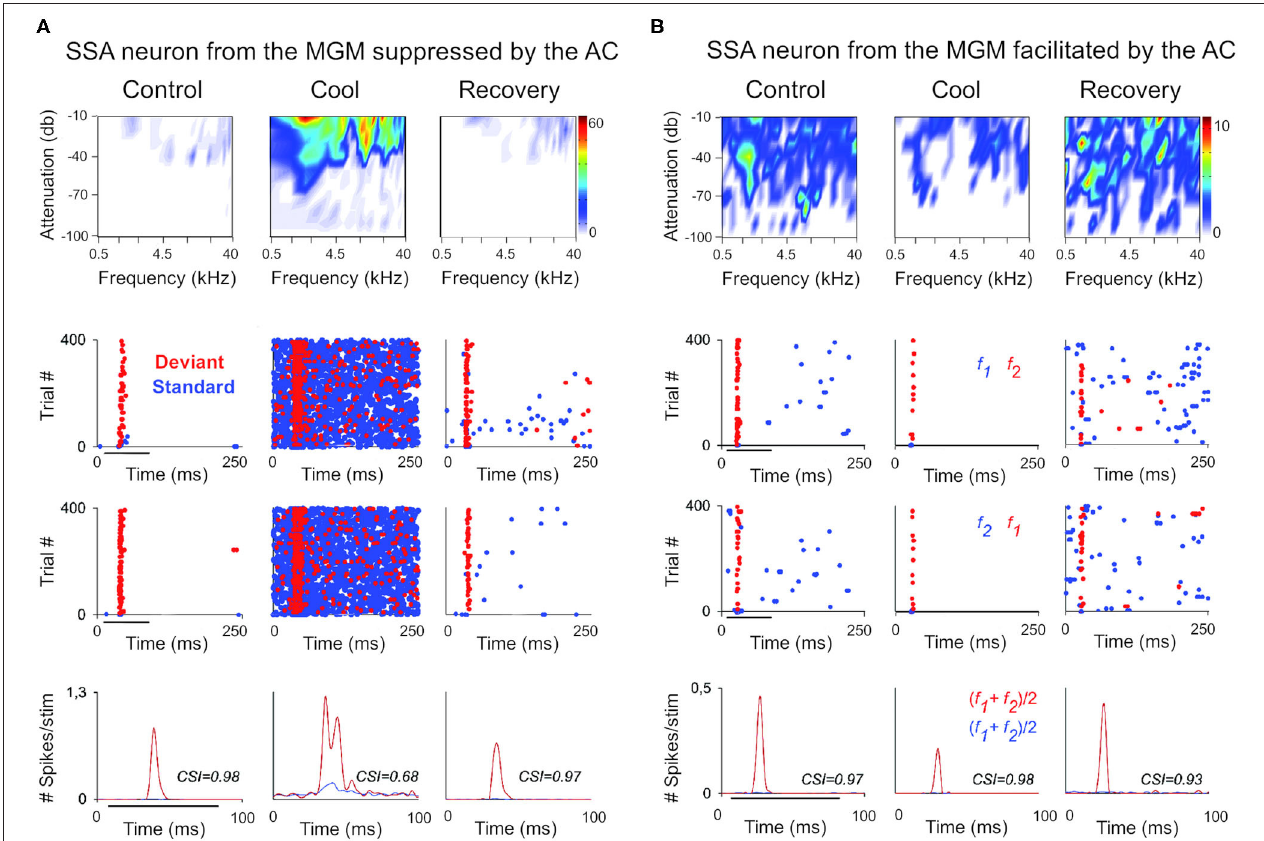
FIGURE 2 | The cortex exerts suppressive and facilitating influences in neurons of the auditory thalamus. Examples of single-unit responses to auditory stimulation in the MGB of the anesthetized rat before, during, and after AC deactivation by cooling. (A) A neuron localized to the MGM that receives suppressive influences from the AC. The frequency response areas (first row), and the responses of the neuron to the oddball paradigm (second-fourth rows), in the control, cool and recovery conditions. The oddball paradigm was used to elicit SSA in these neurons. Briefly, the oddball paradigm consisted of a sequence of a repetitive stimulus (standard; 90% probability) that was infrequently interrupted by a different stimulus (deviant; 10% probability. The standard (blue) and the deviant (red) stimulus were pure tones selected from within the frequency response area of the neuron. Two blocks of 400 trials each (middle panels) were presented in which the standard and deviant frequencies were reversed (second panel, first block: f1/f2 as standard/deviant; third panel, second block: f2/f1 as standard/deviant). Dot rasters show individual spikes to the deviant and standard (red and blue dots, respectively), in the three conditions for the two stimulus presentation blocks (stacked along the y-axis; repetition rate 4Hz; stimulus duration: 75ms, black horizontal lines under the plots). PSTHs (last row) show the number of spikes/stimulus (bin duration: 3ms) averaged over the two blocks [(f1 + f2)/2; blue line is standard, red line is deviant]. The CSI calculated for each condition is noted as an inset on the PSTHs. The CSI quantifies the amount of SSA and is calculated as CSI = [d(f1) + d(f2)-s(f1)-s(f2)]/[d(f1) + d(f2) + s(f1) + s(f2)], where d(fi) and s(fi) are responses (# spikes/stimulus) to frequency fi when deviant or standard, respectively (0 ≤ CSI ≤ 1). Higher CSI values, higher SSA. (B) Responses of another neuron localized to the MGM that